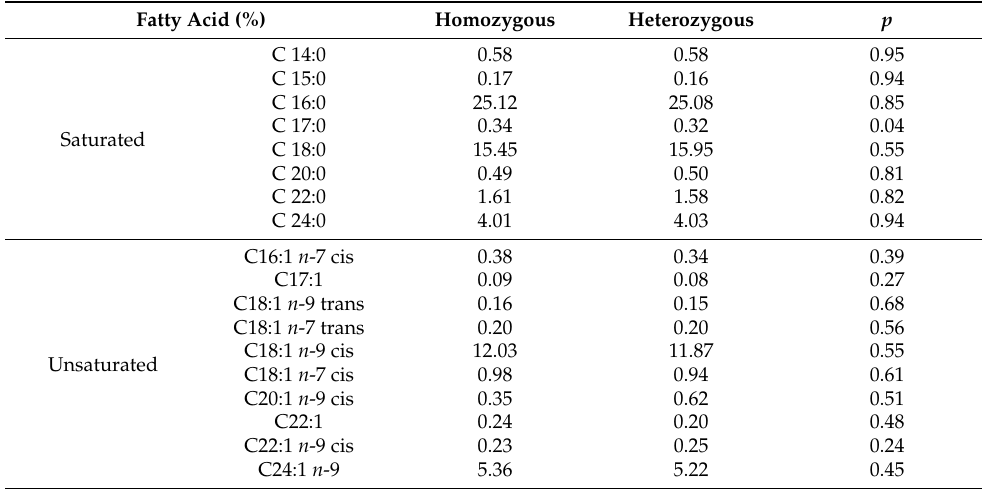
Table 3. Mean percentage of fatty acids in the erythrocyte membrane in the homozygous and heterozygous